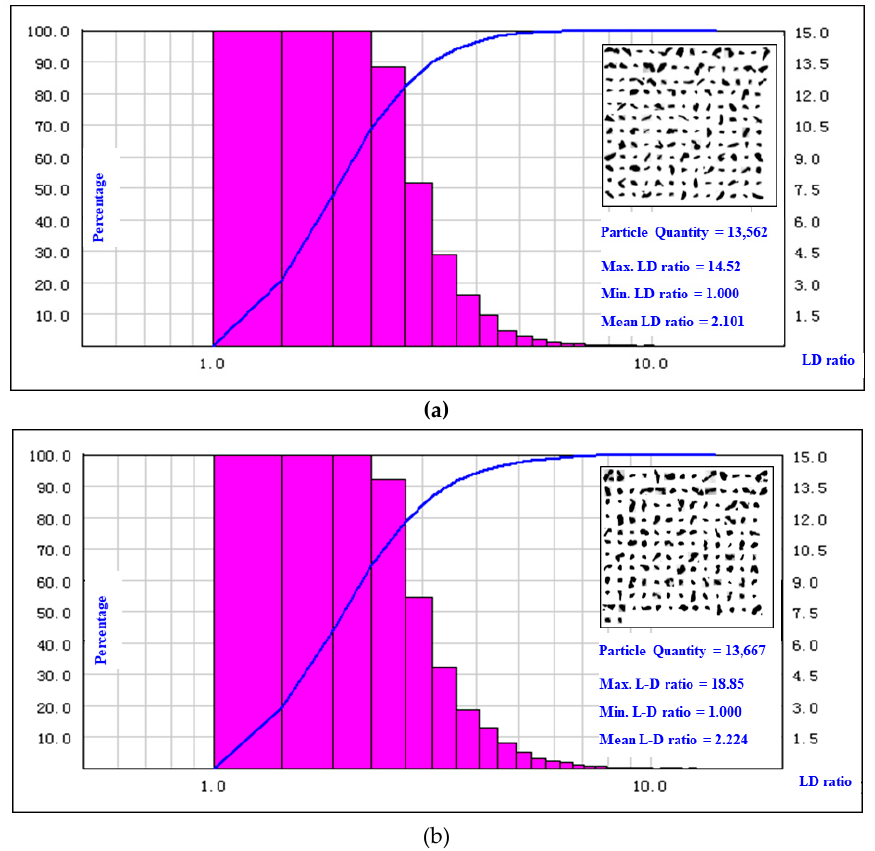
Figure 5. The length–diameter ratio of 0.5–0.25 mm low-rank coal particles: ( a ) rod-milled products, ( b ) crushed products.